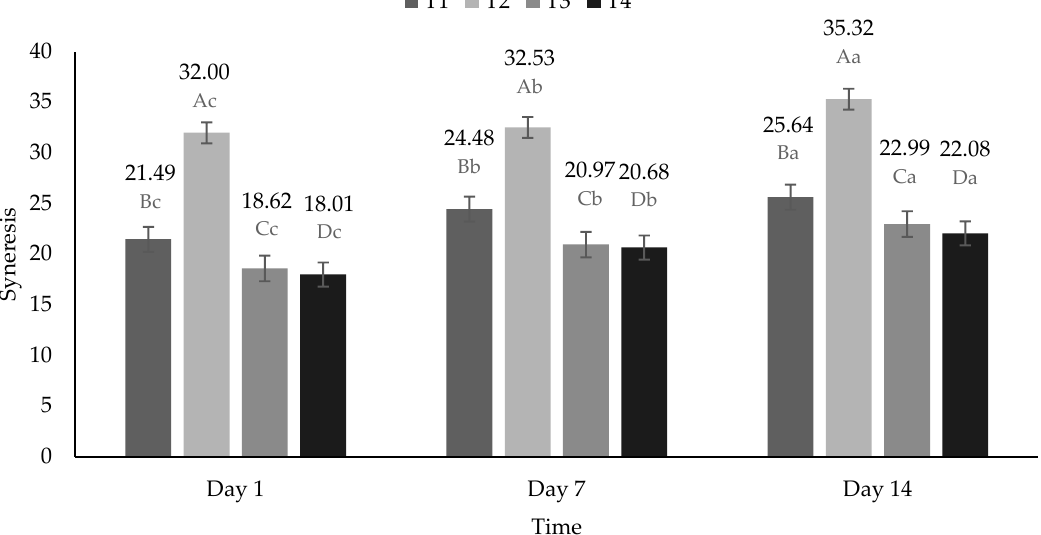
Figure 2. Percentage of syneresis of yogurt added with beet extracts. T1 = Natural yogurt (Y), T2 = Y added with beet juice, T3 = Y added with extract encapsulated with Maltodextrin, and T4 = Y added with extract encapsulated with Inulin. A,B,C,D Values with different superscript indicate significant statistical difference between treatments ( p < 0.05). a,b,c Values with different superscript indicate statistical difference significant over time ( p < 0.05).